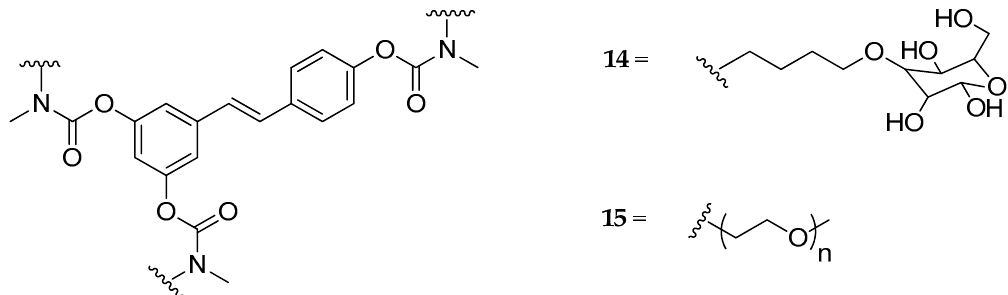
Figure 8. Chemical structures of N , N -disubstituted carbamoyl-RSV derivatives 14 , and 15 .